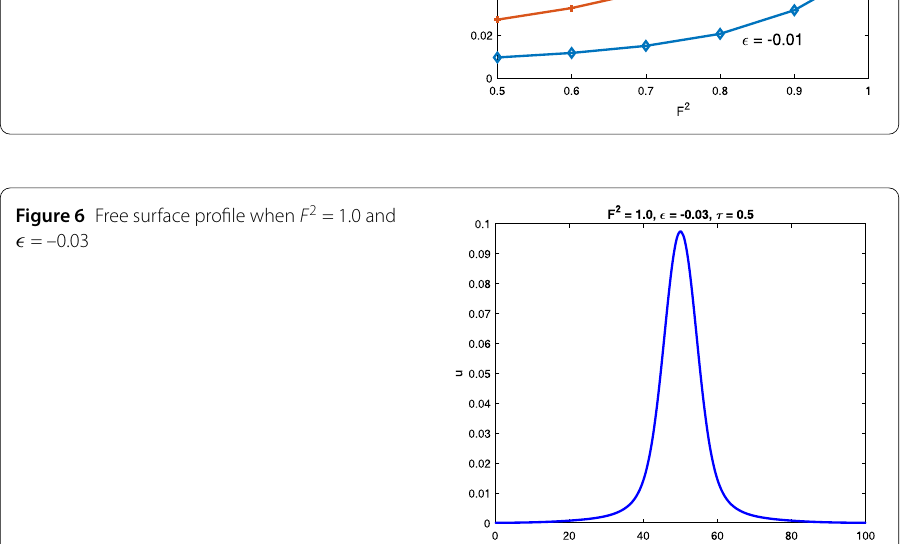
Figure 5 Branch of elevation wave for subcritical flows